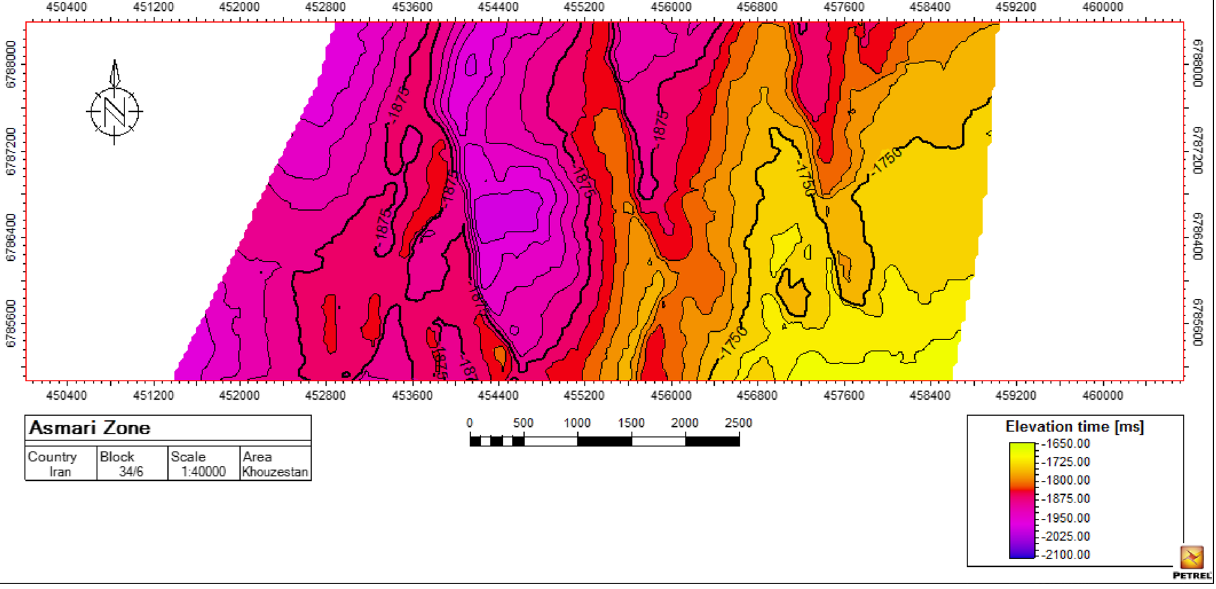
Fig. 4 Interpretation of the Asmari zone (Petrel E&P